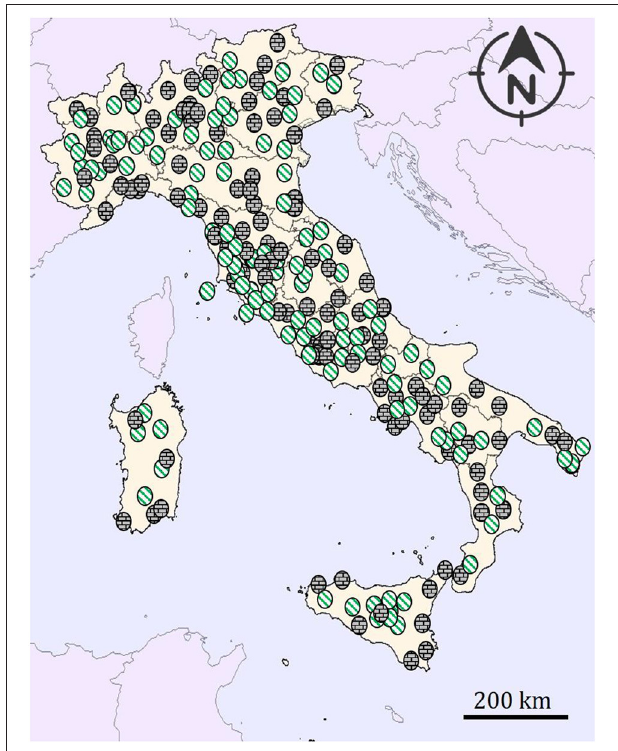
FIGURE 2 | Locations of origin of our data, including rural areas (green-lined circles) and urban centers (gray-bricked circles). Killings recorded far from owner’s house (including those from smaller islands), i.e., with cats moving with prey in their mouth, were not shown in this